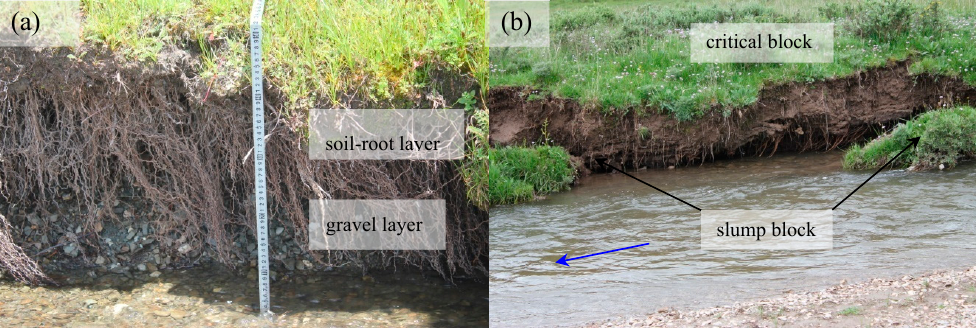
Figure 2. The outer bank of the meandering bend. ( a ) The exposed soil-root layer after bank failure; ( b ) the cantilever slump blocks and critical blocks.